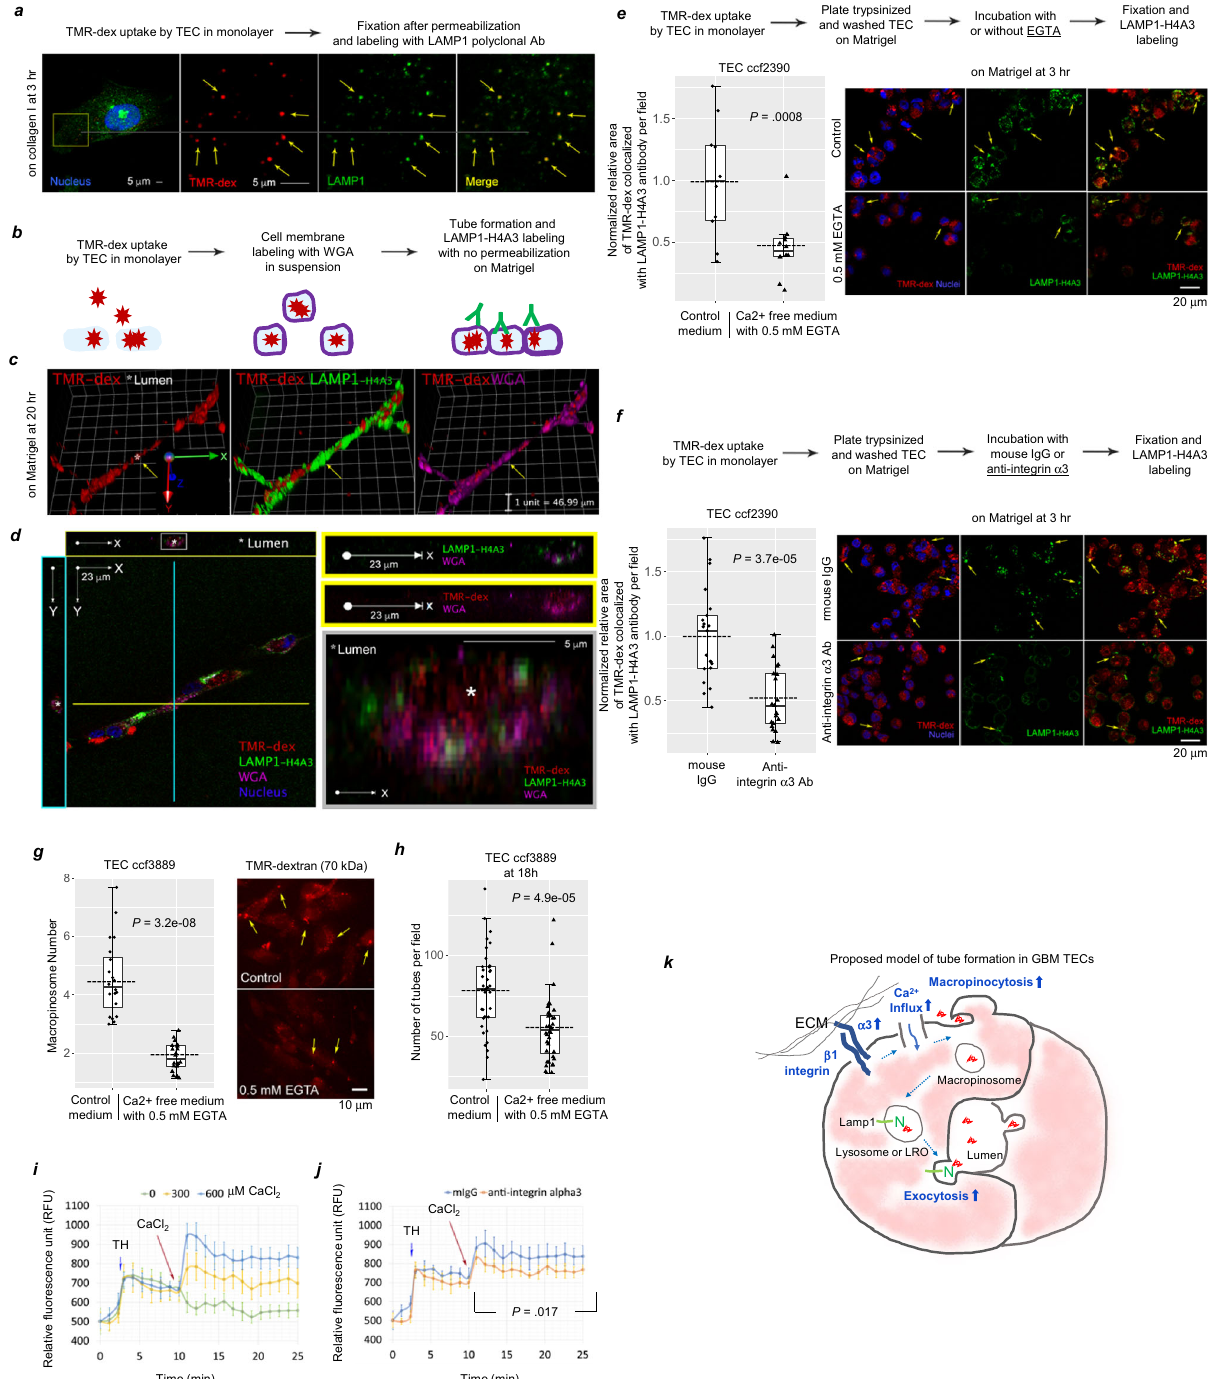
integrin α 3 β 1 and CD151 in tumor cells in GBM have been reported to be prognostic markers of poor survival 55 . The concept that this upregulation of integrin α 3 β 1 is a driver of tumor- associated angiogenesis is supported by the observation that blockade of integrin α 3 β 1 greatly reduced sprout formation, implicating α 3 β 1 in this aspect of angiogenesis that likely expands the tube networks, and tube formation. Moreover, blockade of GBM tumor, probably by targeting both vessel formation and angiogenesis. The reduced vessel density observed on blockade of integrin α 3 β 1 could be due to the destabilization of the existing